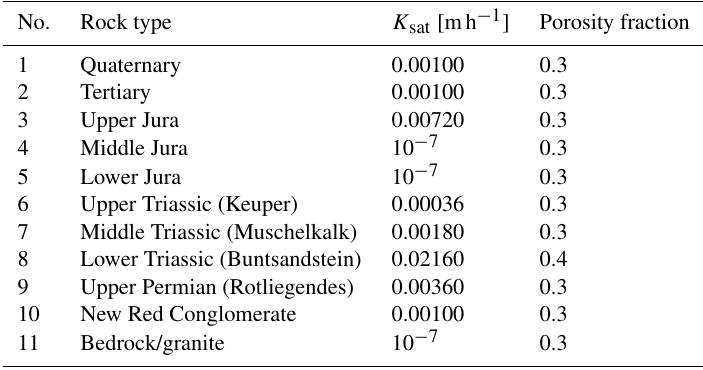
Table A1. Values of porosity and hydraulic conductivity of rocks found in Baden-Württemberg.